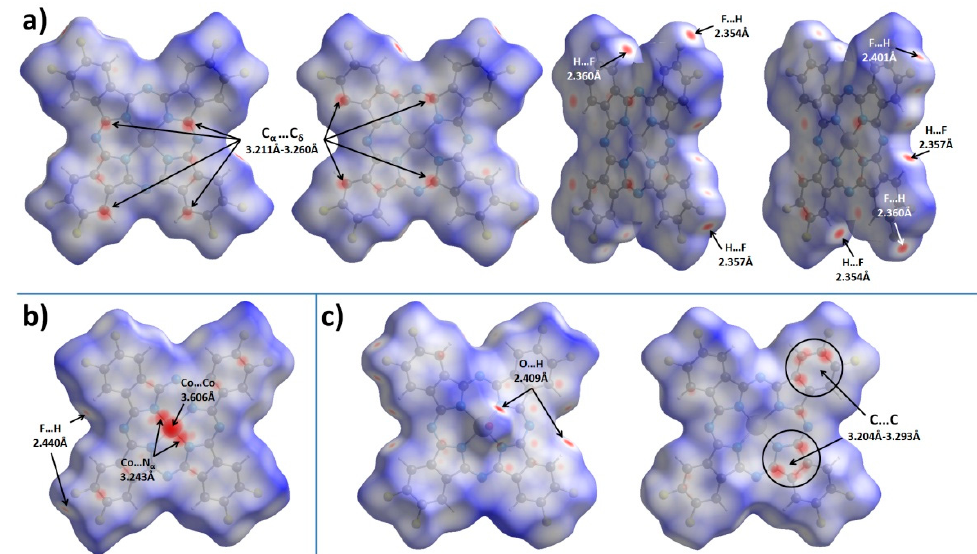
Figure 4. Hirshfeld surfaces for ZnPcF 8 ( a ), CoPcF 8 ( b ), and VOPcF 8 ( c ), mapped with the d norm property in the range of − 0.2 − 1.45.